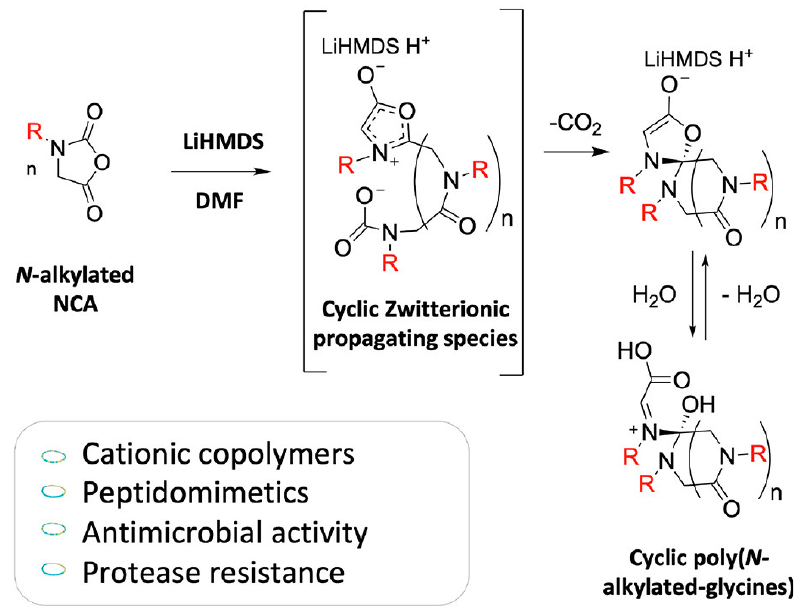
Figure 10. The self-assembly of two peptoid molecules with two Cu 2+ ions has led to the formation of a highly symmetric macrocycle and two aquabridged dimeric complexes that can be described, as dinuclear double-stranded peptoid helicates (Adapted from ref. [83]. Copyright 2018, Wiley-VCH Verlag GmbH & Co. KGaA, Weinheim).